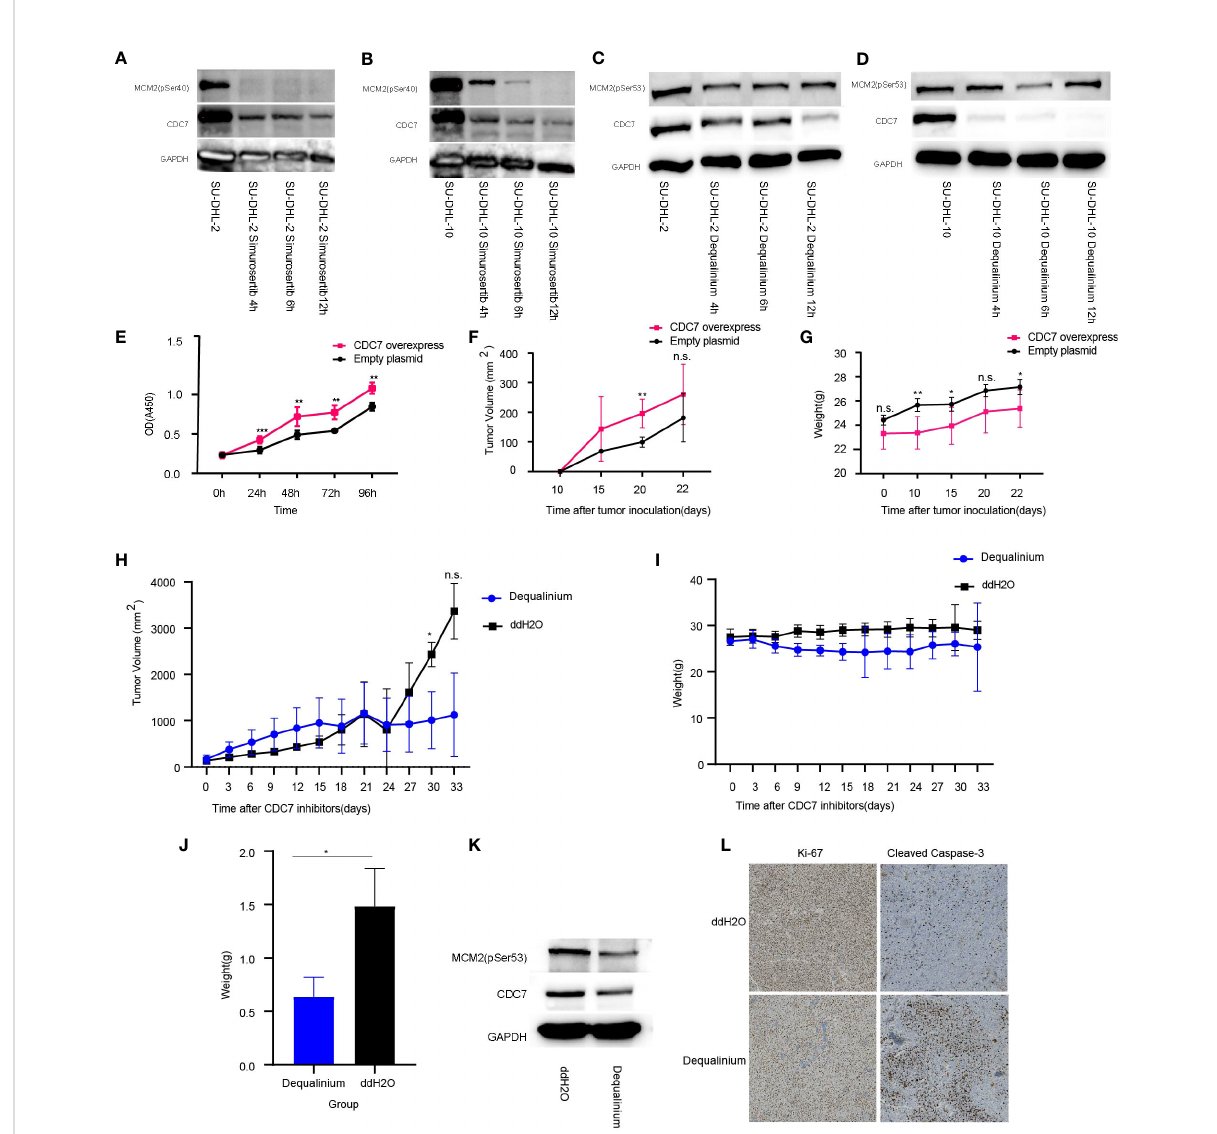
FIGURE 6 CDC7 over-expression promotes lymphoma growth, which is reversed by dequalinium. (A, B) Effect of simurosertib-treated SU-DHL-2 and SU- DHL-10 cells after incubation for 4, 6, and 12 h in vitro . (C, D) Effect of dequalinium-treated SU-DHL-2 and SU-DHL-10 cells after incubation for 4, 6, and 12 h in vitro . (E) Viability of CDC7 over-expression using the cell counting kit-8 (CCK-8); (F) Lymphoma volume of BALB/c mice with CDC7 -over-expressing and empty plasmid-transfected SU-DHL-10 cells; (G) Mice weight of BALB/c mice with CDC7 -over-expressing and empty plasmid-transfected SU-DHL-10 cells; (H) Lymphoma volume of BALB/c mice implanted with SU-DHL-10 cells given dequalinium or placebo as described; (I) Mice weight of BALB/c mice implanted with SU-DHL-10 cells given dequalinium or placebo; (J) Weight of tumors removed from BALB/c mice implanted with SU-DHL-10 cells receiving dequalinium or placebo; (K) Effect of dequalinium-treated lymphoma from mice; (L) Immunohistochemistry was conducted for lymphoma from mice. Tumors were stained for human Ki-67 and human cleaved caspase-3. Data are means ± standard deviation (SD), * P < 0.05, ** P < 0.001 and ***P < 0.0001, n.s., no signi fi